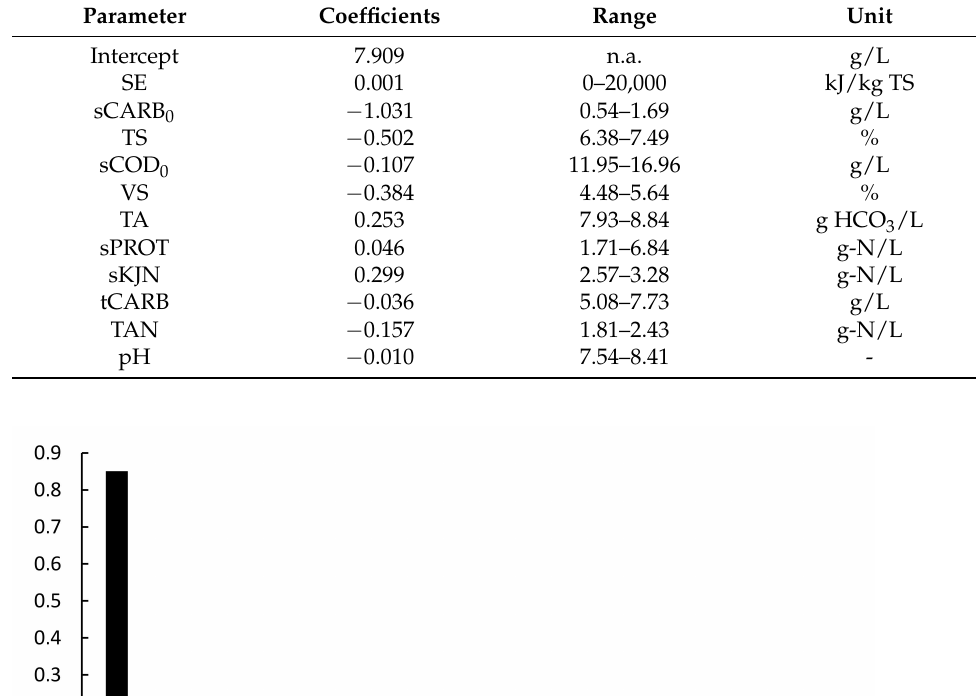
Table 6. Resulting variable coefficients and corresponding variable ranges and units.